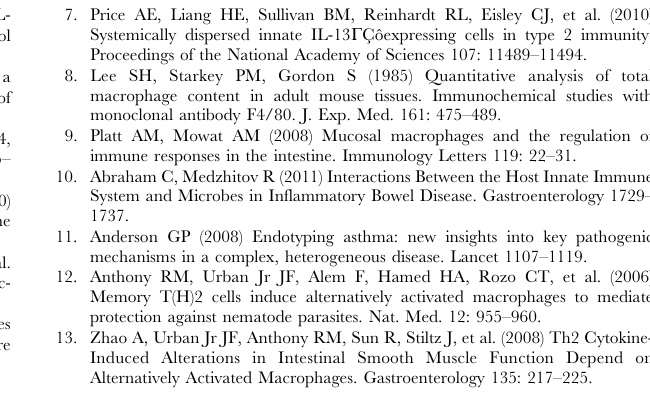
Figure S2 IL-13-expressing macrophages in the spleen and intestinal mucosa. Mice were infected with Heligmosomoides bakeri ( H. bakeri) . Sections of intestine were stained with anti-F4/80 (green) and anti-IL-13 (red). Images are the representative from two independent experiments (n = 5 per group).